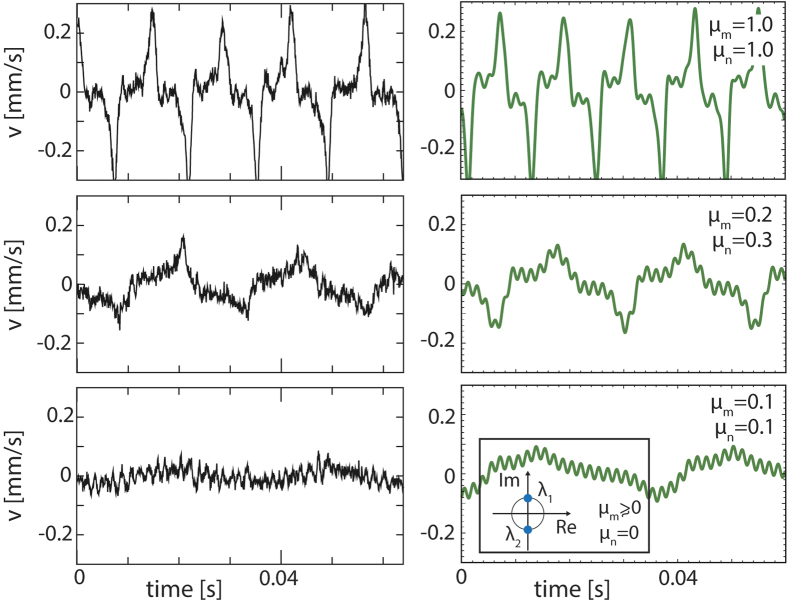
Top to bottom: From self-sustained antenna oscillations back to the quiescent fixed-point.Left column: experimental data from30, right column: simulation, where the polynomials were reduced by factors μm ≃ μn. Close to bifurcation, μn precedes μm, so that at bifurcation μm > 0. Inset: At crossing to quiescence, the linear analysis reveals a Hopf bifurcation26.